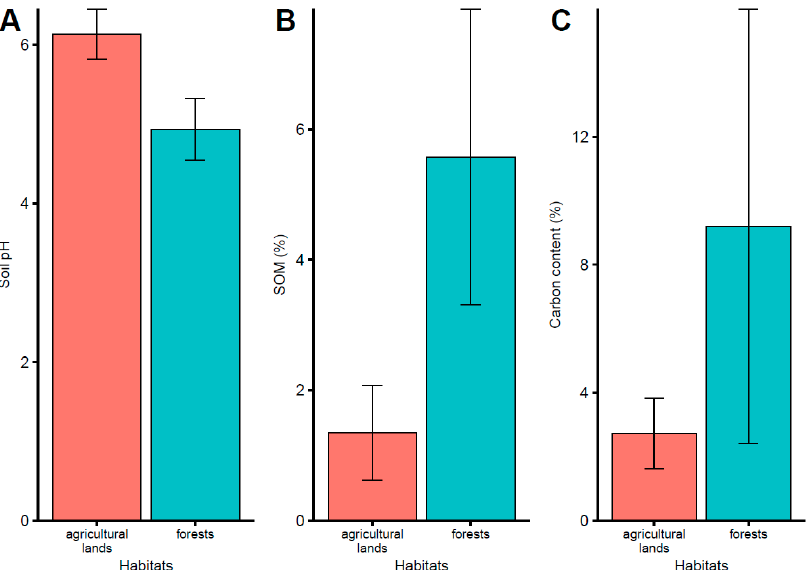
Figure 2. Soil pH ( A ), soil organic matter ( B ), and carbon content ( C ) reported from agricultural areas and from post-agricultural forests based on literature survey. Bar plots represent mean values, whereas whiskers represent standard deviation (SD). Table 1. Summary of the studies investigating the communities of soil fauna on post-agricultural lands. Abbreviations indicate: SM—soil moisture, SOM—soil organic matter. Age class of forests were applied as follows: 1–30 young forest, 31–80 middle age forest, 81 > mature forest. Summary based on [5,22–34,36].